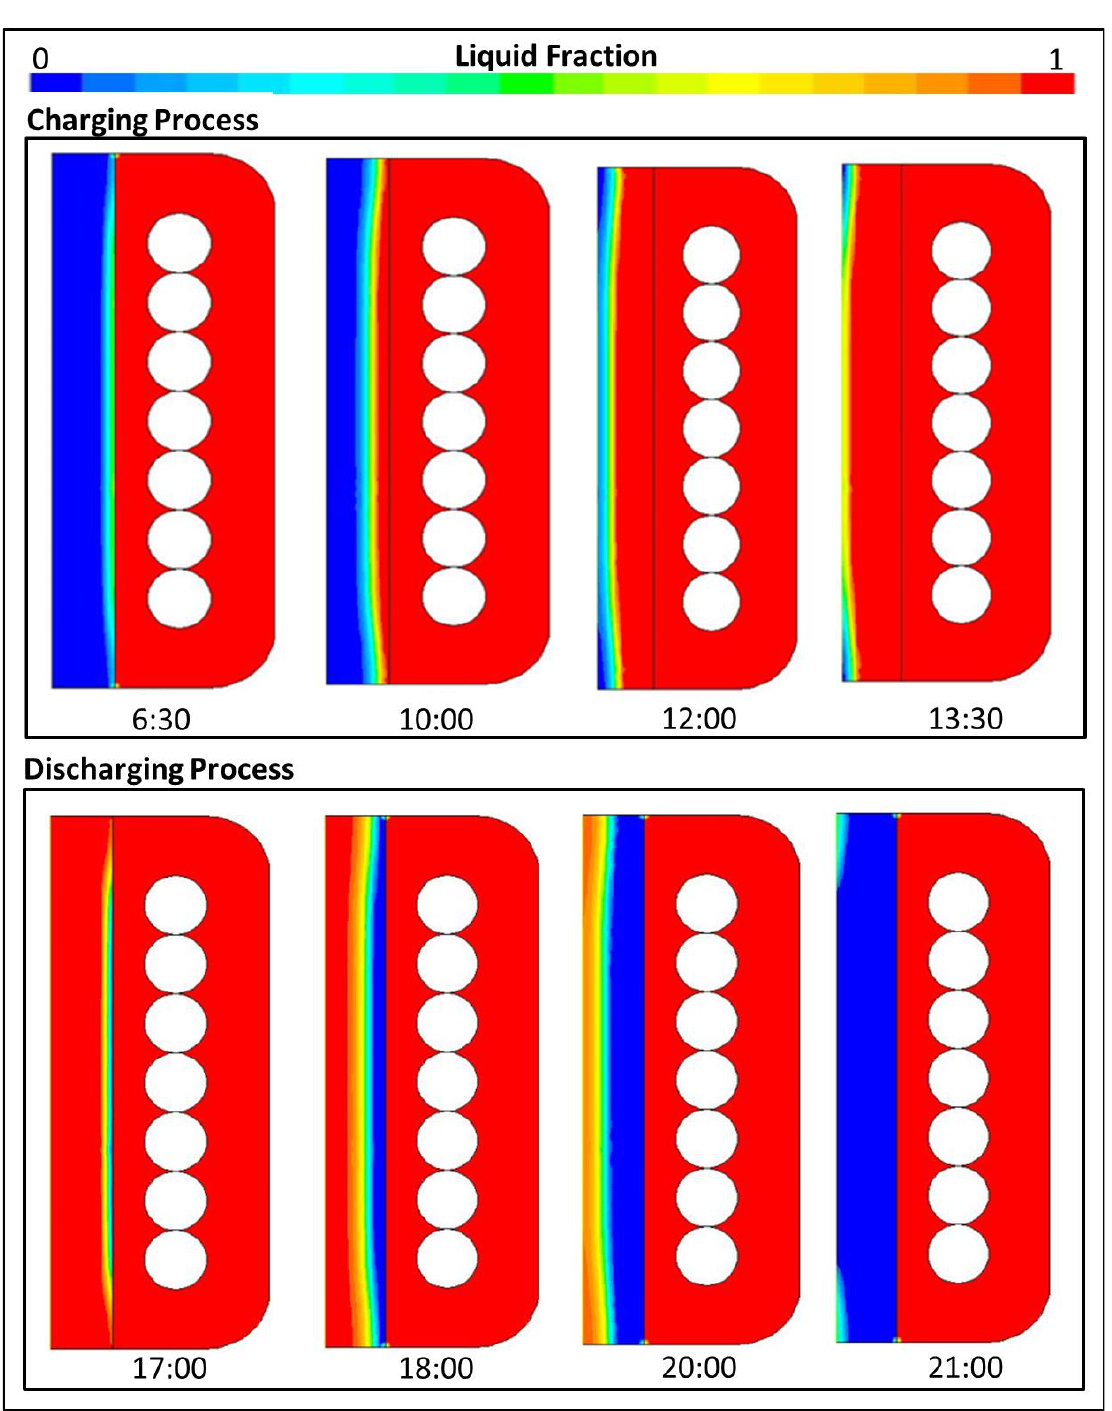
Figure 6. Time distribution of the melted fraction of the PCM at selected times.